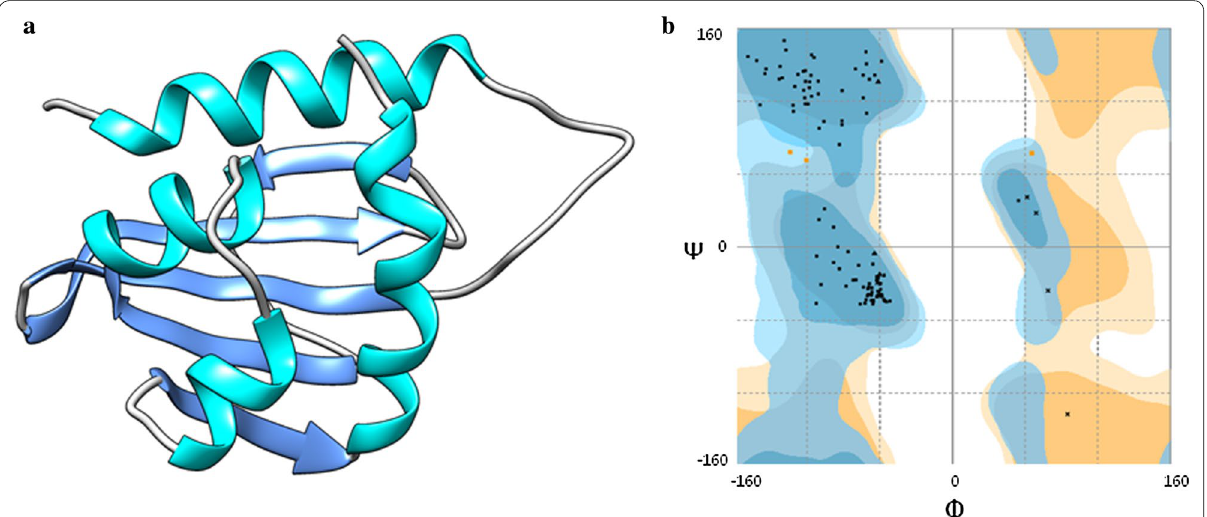
Fig. 6 Results of the construction homology of the sterol carrier protein (SCP‑2). a Model of sterol carrier protein (SCP‑2). b Ramachandran plot corresponding for the model of